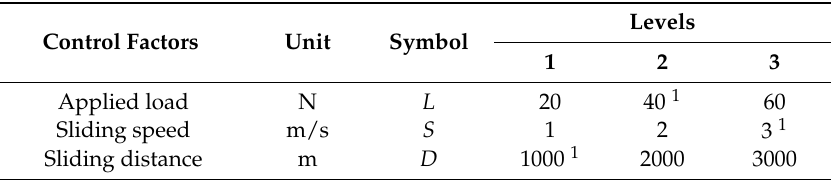
Table 1. Control factors of wear and their